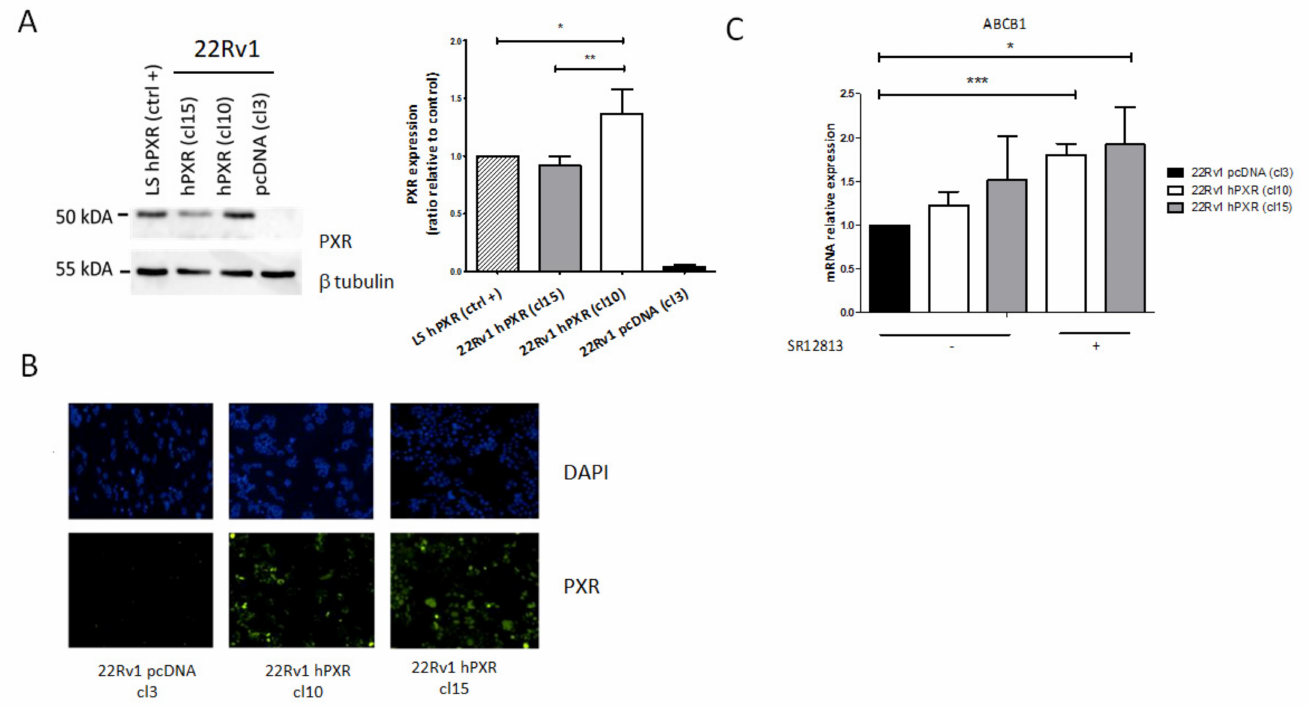
Figure 2. Characterization of 22Rv1 prostate cancer cells stably expressing PXR. Cells were transfected with the pcDNA3 empty vector or the pcDNA3-hPXR plasmid together with the luciferase reporter plasmid XREM-CYP3A4-Luc+ and clones stably expressing PXR (clone 10 and 15) and control clone (clone 3) were selected by limiting dilutions in the presence of antibiotics. ( A ) Evaluation of PXR protein expression by Western blotting. PXR expression was quantified using the